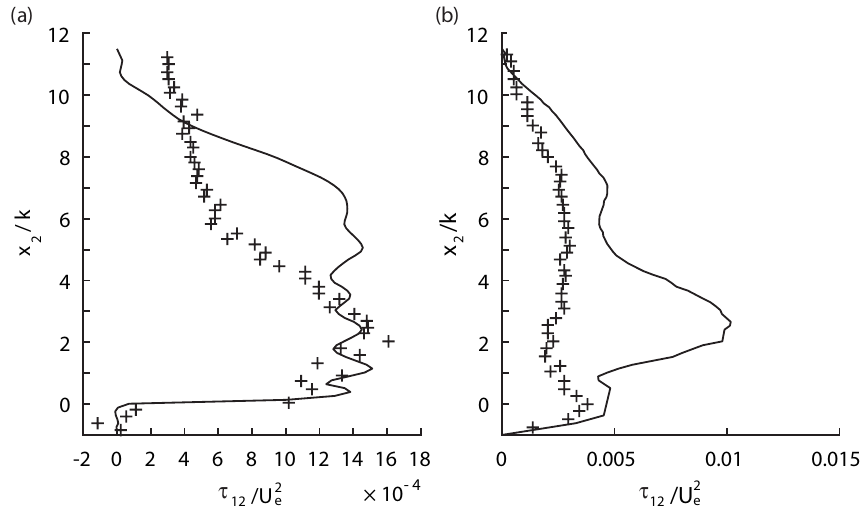
Figure 13. Vertical profile (curve) of predicted Reynolds shear stress τ 12 for: ( a ) Run 1; ( b ) Run 4, compared with observed values (the plus symbol) [13]. The predicted and observed τ 12 values are the averages over 6.5 ≤ x 1 / λ ≤ 7.5 (panel a) and 4.5 ≤ x 1 / λ ≤ 5.5 (panel b) at x 3 = 0.0375